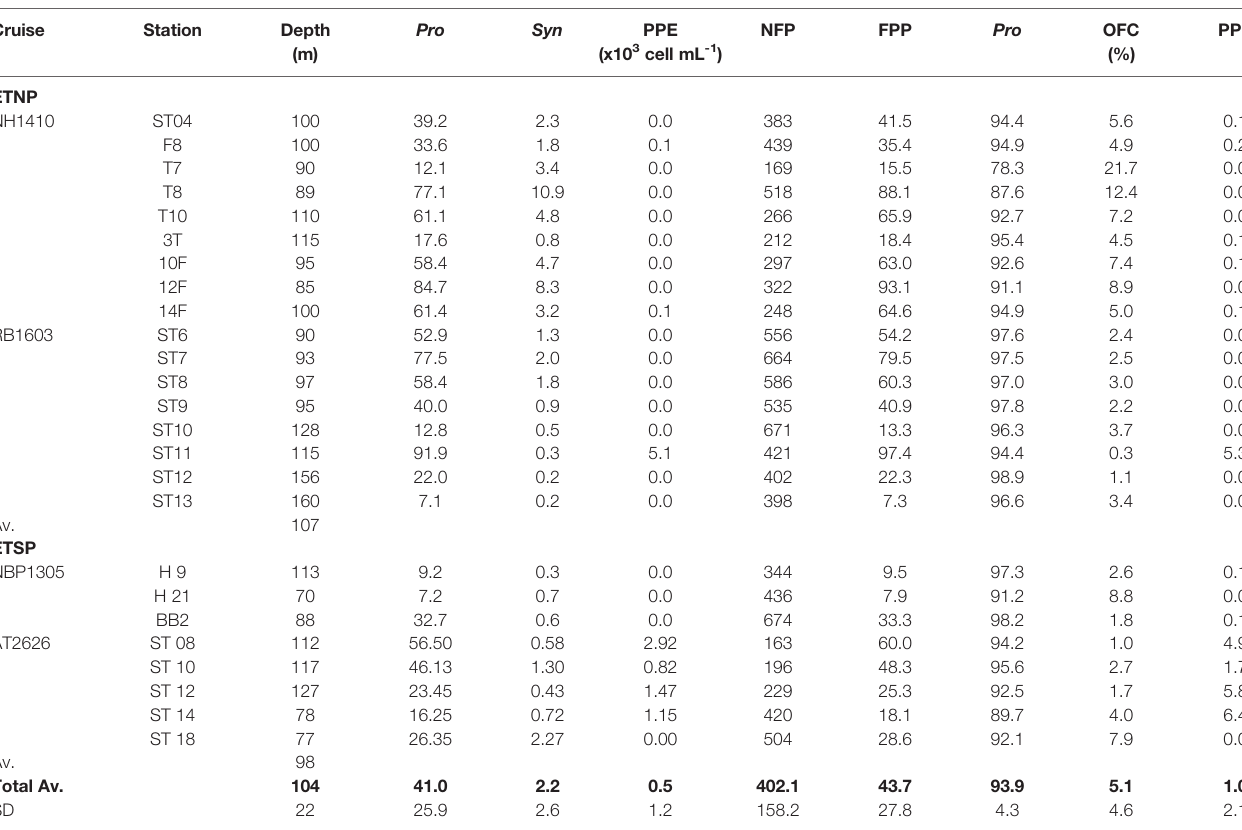
TABLE 1 | Flow cytometric analysis of the microbial community at the peak depth of the secondary chlorophyll maximum (SCM) for the Eastern Tropical North Paci fi c (ETNP) and Eastern Tropical South Paci fi c (ETSP), including: cruise name; station; peak depth of the SCM in meters; Prochlorococcus ( Pro ), orange- fl uorescent cells (OFC), photosynthetic picoeukaryotes (PPE), non- fl uorescent picoplankton (NFP), fl uorescent picoplankton (FPP = Pro + Syn + PPE) abundances (x10 3 cells mL -1 ); Pro , Syn and PPE relative abundances (in %) to the fl uorescent picoplankton. Cruise